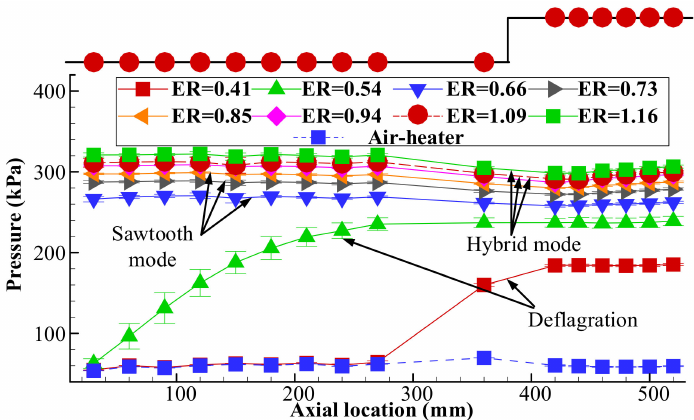
Figure 11. Pressure distribution in the streamwise direction for D exh = 68 mm and D c = 112 mm with different ER values.